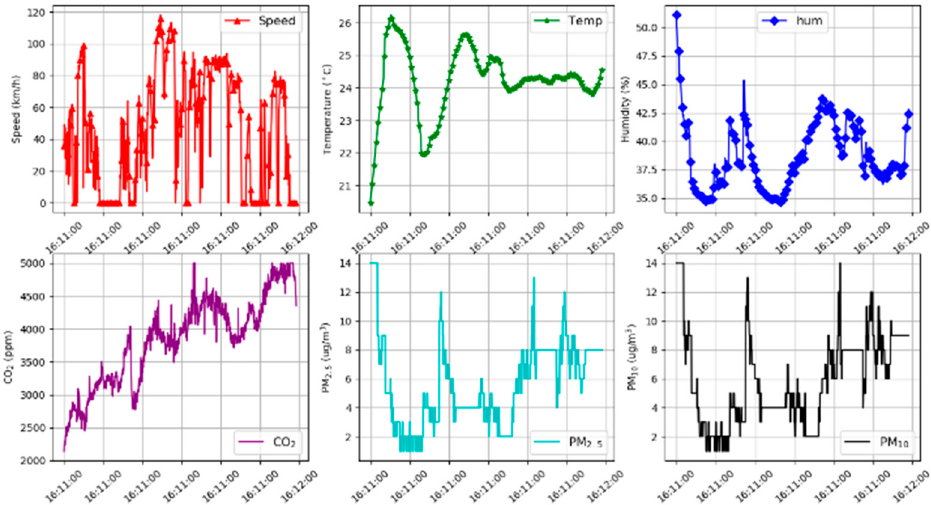
Figure 6. The raw section sensor data plotted for each parameter.